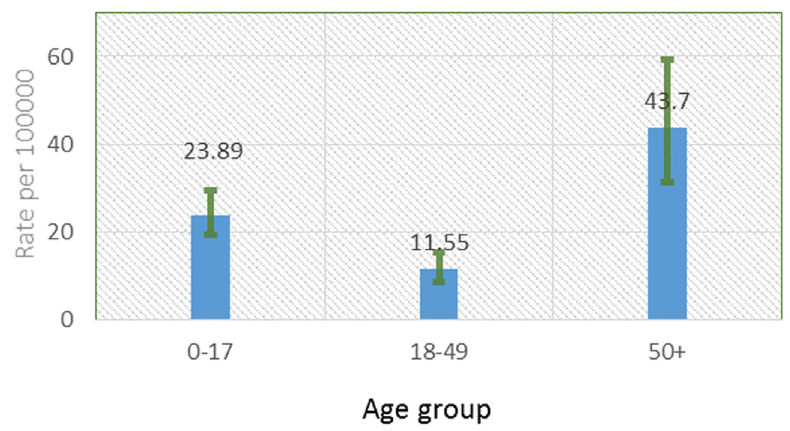
Figure 1. Annual incidence of lightning injuries by age